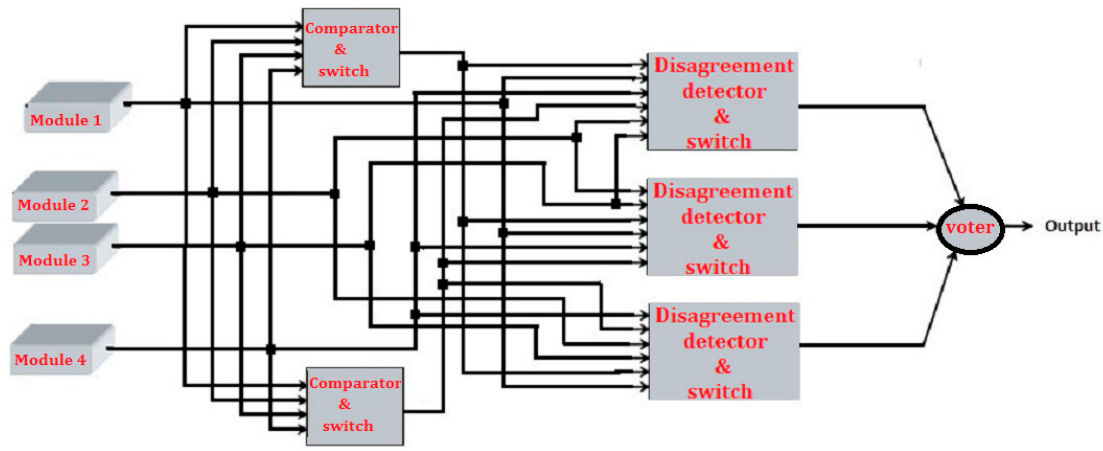
Figure 2. Proposed four modules redundancy.